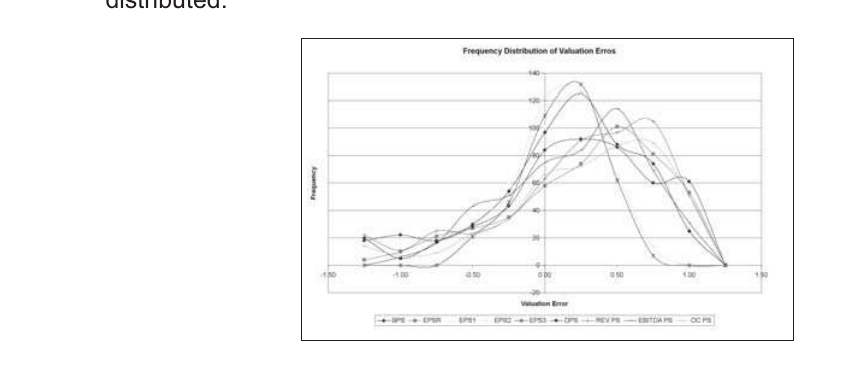
Figure 12 Combined Frequency Distribution of graph of all value driver valuation